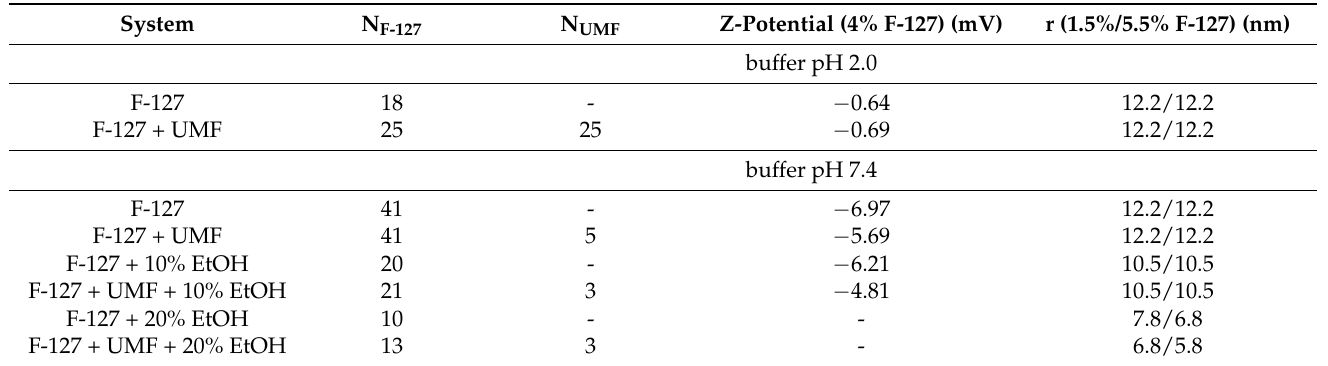
Table 2. Numbers of pluronic F-127 (N F-127 ) and UMF (N UMF ) molecules in the micelle, zeta potential (Z-potential) of pluronic F-127, and micelle size (r) with and without UMF in the studied